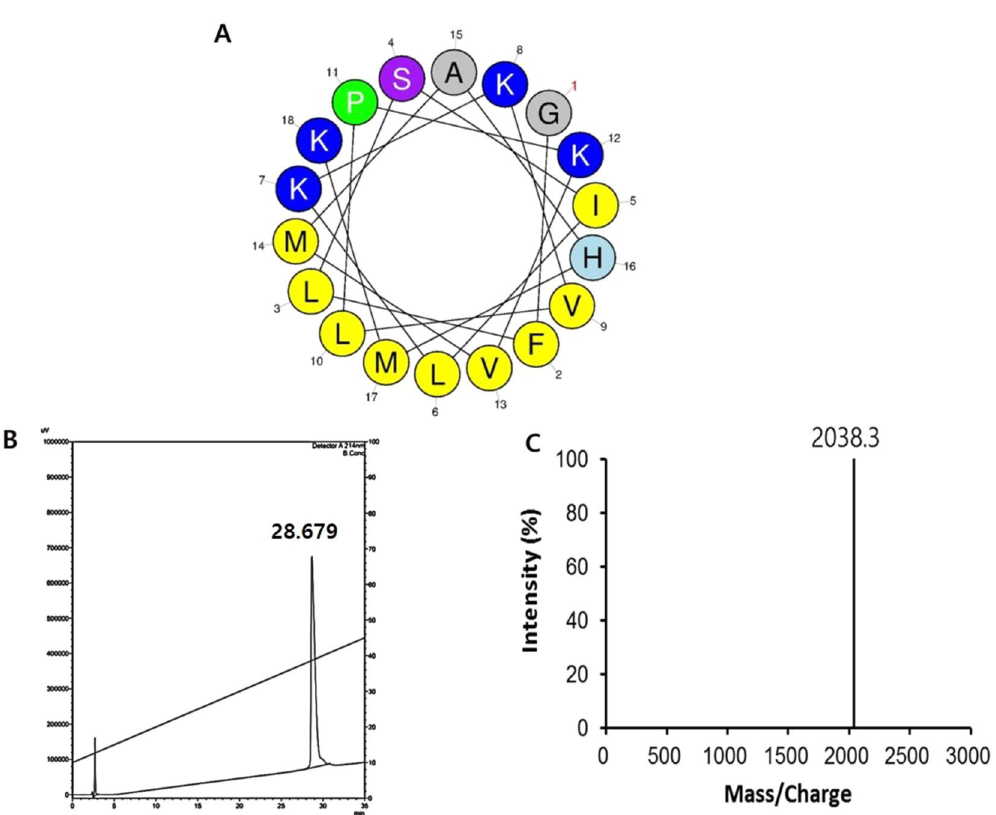
Figure 1. Helical wheel diagram of the peptide. ( A ) The projections were obtained from http://heliquest.ipmc. cnrs.fr/cgibn/ComputParam.py 41 . Yellow indicates hydrophobic residues. Blue indicates positively charged residues. Gray represents other residues. ( B ) Reverse-phase HPLC (RP-HPLC) profile on a C18 column with detection at 214 nm. The black arrow represents the retention time of melectin (29.960 min). ( C ) MALDI